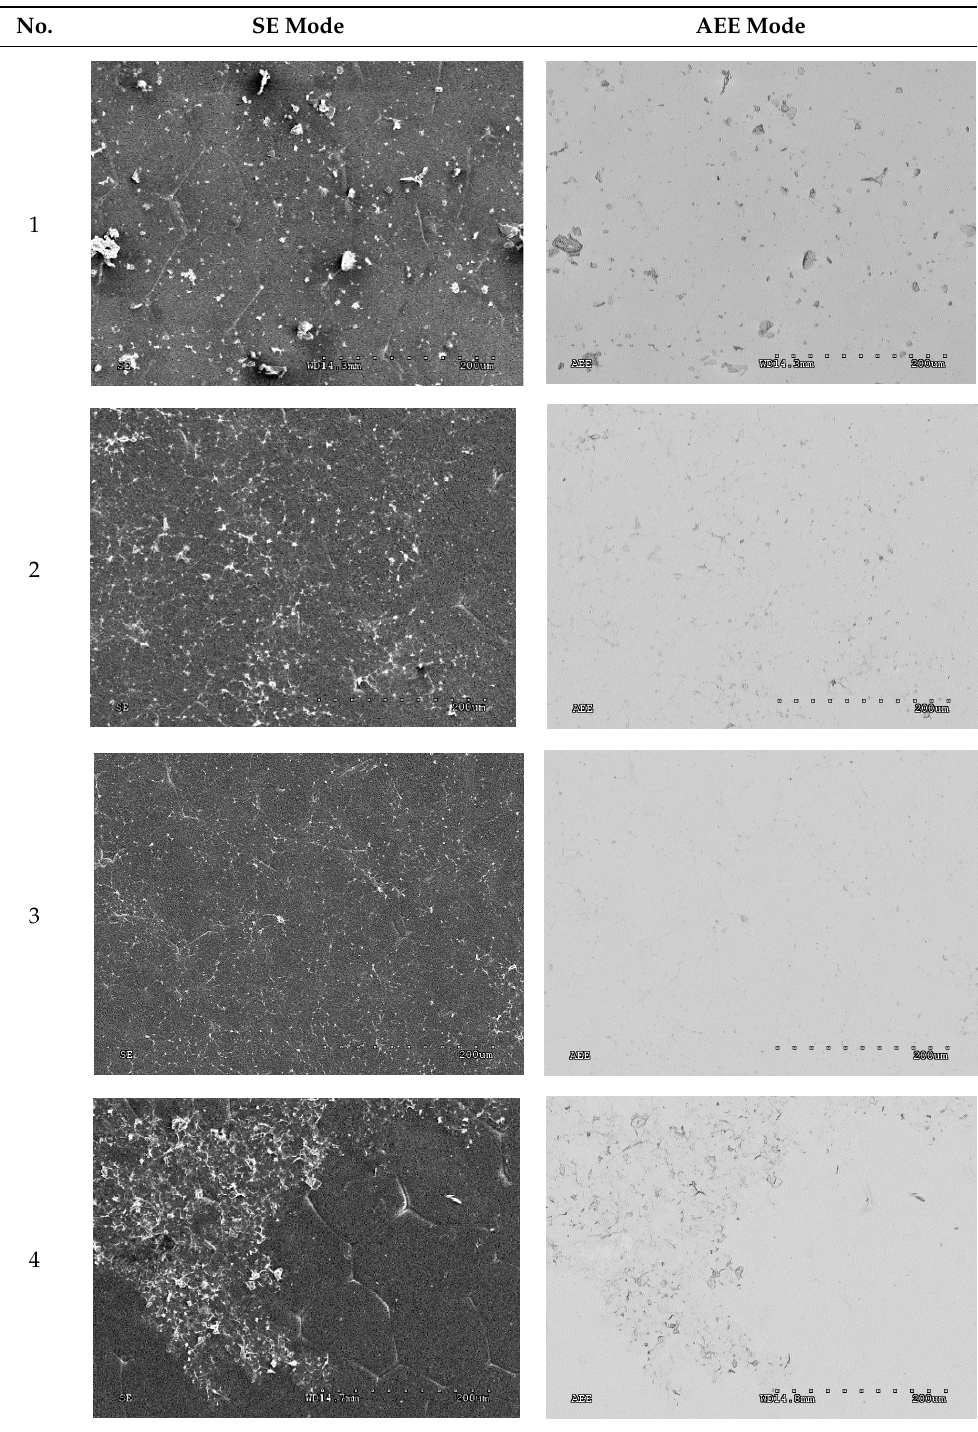
Table 4. SEM images of graphene/rGO membranes.